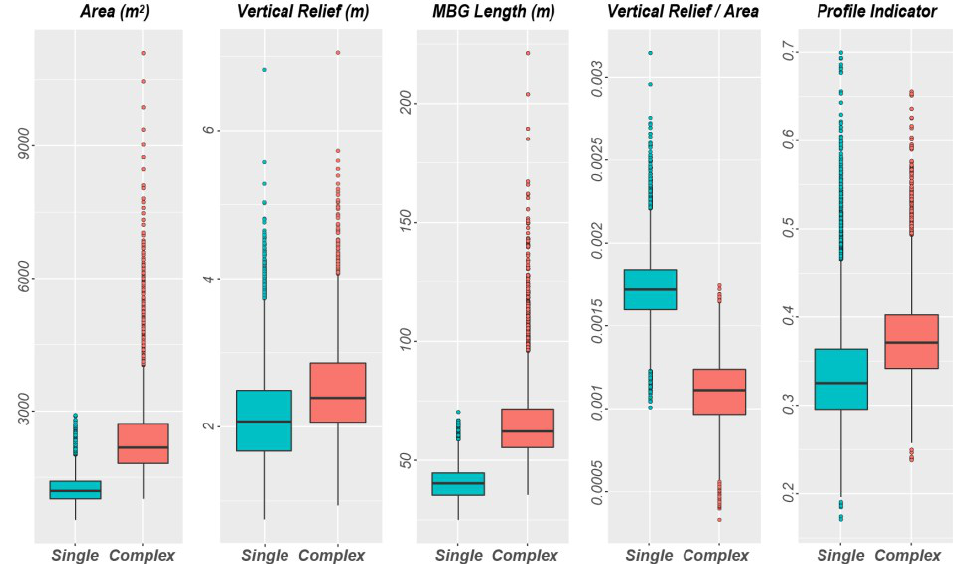
Figure 20. Box plot for the Area, Vertical Relief, MBG Length Vertical Relief/Area ratio, and PI measured for both the single and complex pockmarks mapped.